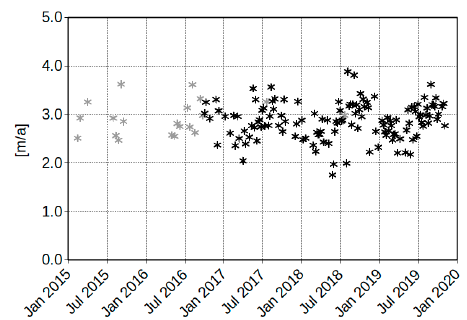
Figure 9. Velocity along the maximum slope direction at the front of Manissuarsuk rock glacier (Qeqertarsuaq, Western Greenland) from Sentinel-1 InSAR. Grey indicates 12 day time interval and black indicates 6 day time interval. For position see Figure 8a.